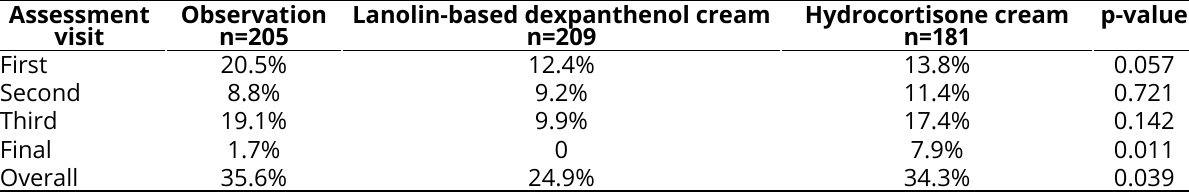
Table 2. Frequency of hand-foot syndrome along the study (see text for timing of visits).